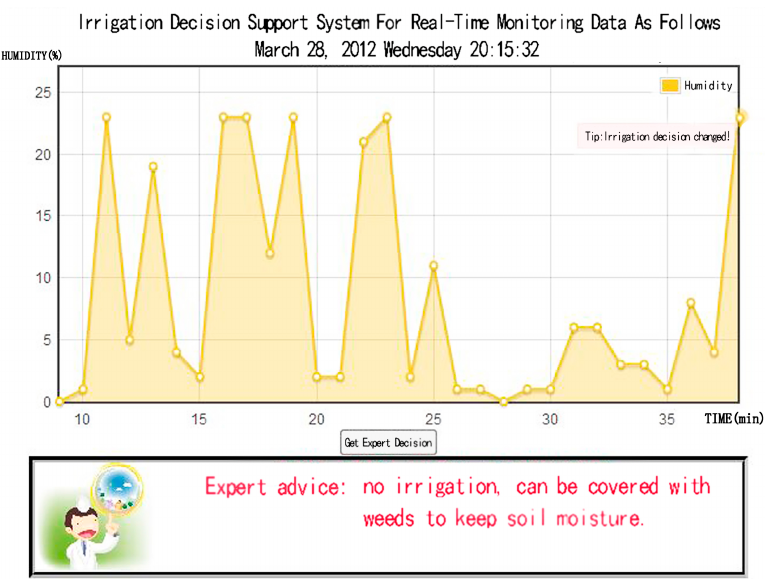
Figure 8. Irrigation decision support interface.